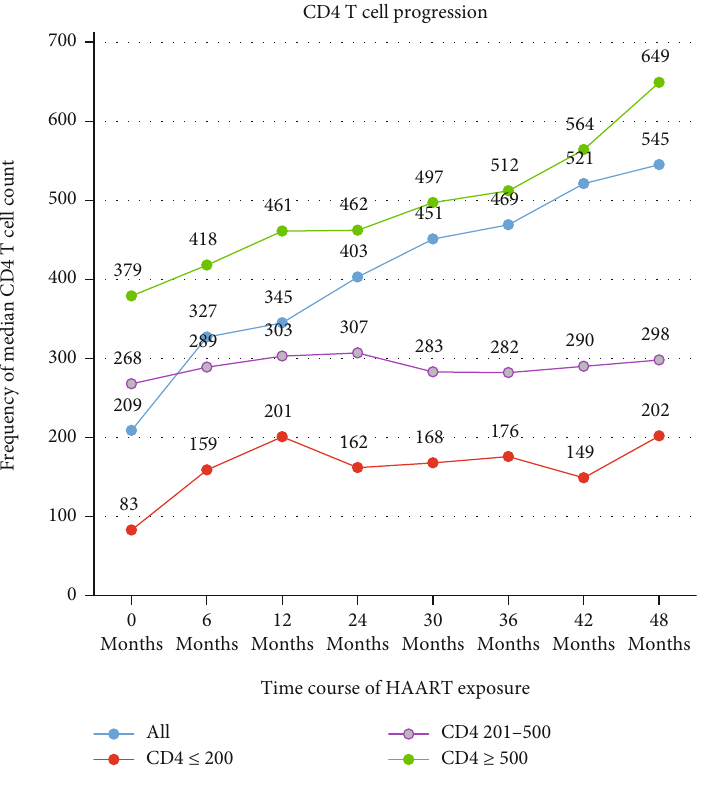
Figure 1: Trends of median CD4 T cell count at baseline and 48 months of HAART